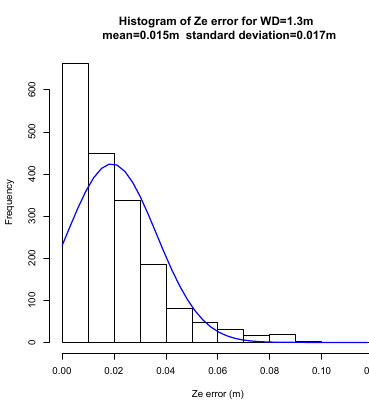
Figure 25. Histogram of Z e error for WD = 1.3 m. The curve in blue is the curve estimated by R as the Gaussian curve that is closest to the obtained data.